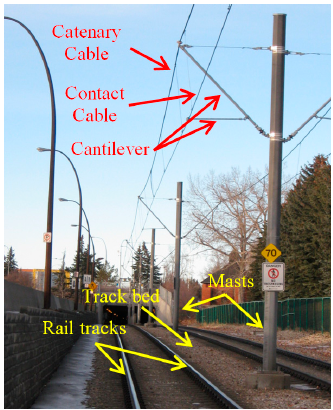
Figure 2. Components of an urban railroad corridor.